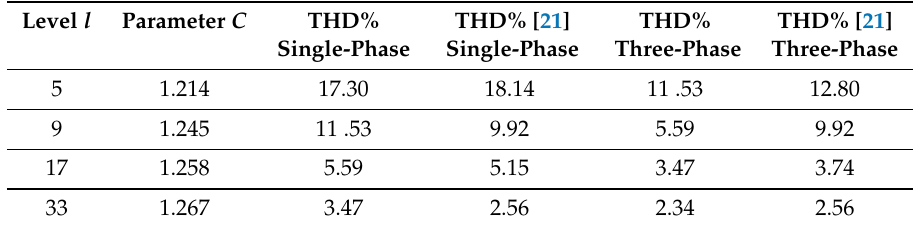
Table 2. Parameter C and THD%.